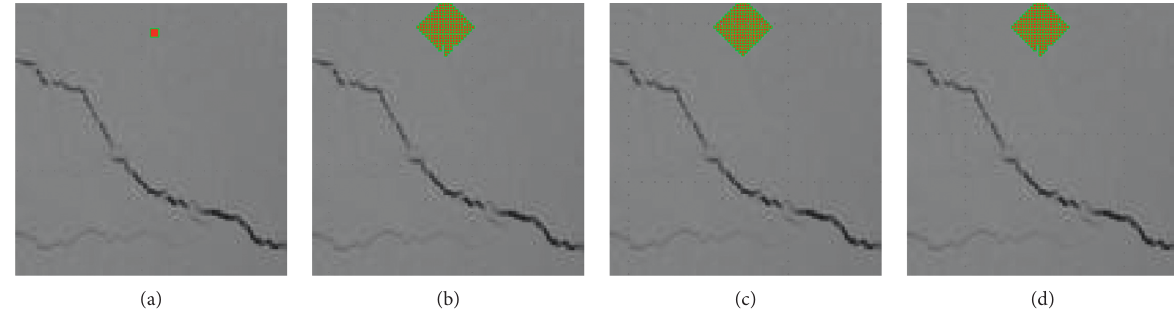
Figure 25: Percolation result of a background pixel using different striding strategies: (a) raw image; (b) fixed stride percolation; (c) linear stride percolation; (d) quadratic stride percolation.